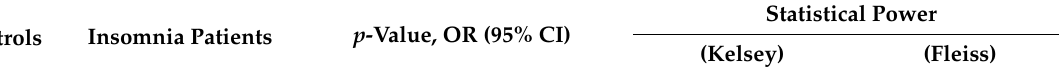
Table 2. Genotype and allelic frequencies of OPN4 in chronic insomnia.